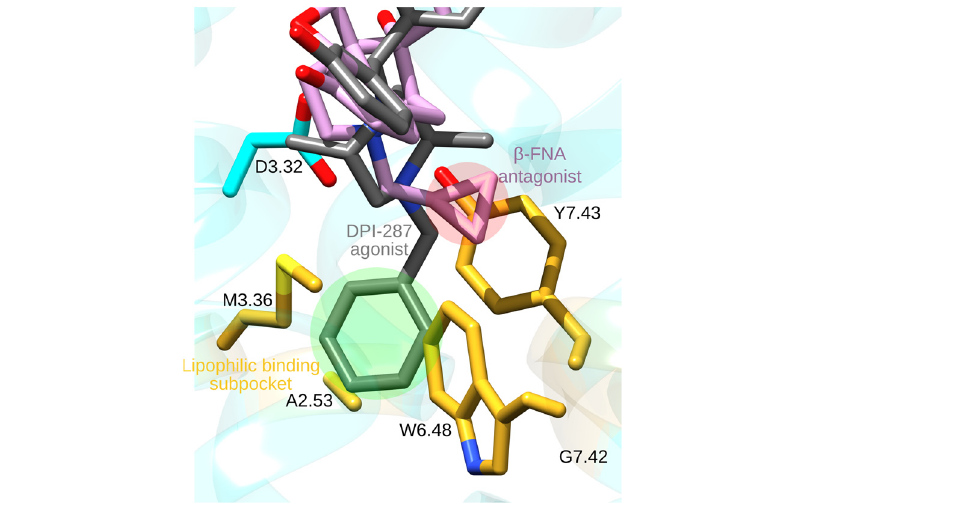
Figure 6. Binding pocket of opioid receptors. The molecular graphics, generated with UCSF Chimera 1.14 [23] and Inkscape 1.0 to add text and highlights, is based on the crystal structure of the DOR bound to the agonist DPI-287 (PDB ID:6PT3) [62]. We generated a structure of the DOR bound to the agonist β -FNA by using UCSF Chimera MatchMaker tool [23,63] to superimpose the DOR to that of the β -FNA-bound MOR (PDB ID: 4DKL). This suggests that the agonist molecule (green highlight) binds deeper than the antagonist (red highlight).